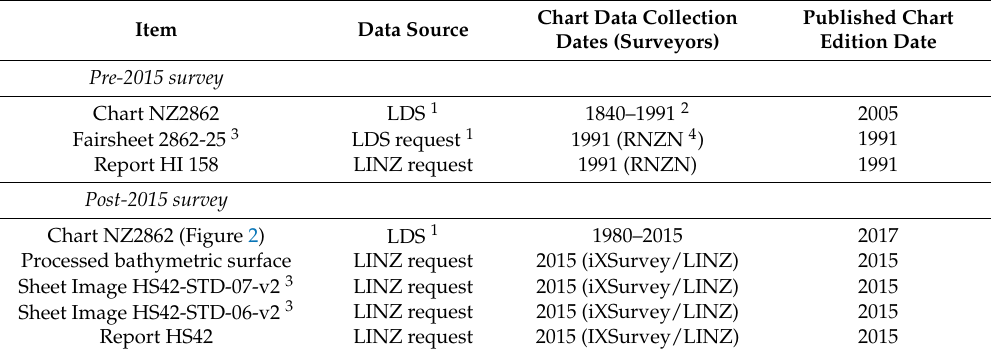
Table 1. Legacy chart data used in the Auckland Islands case study. Item Data Source